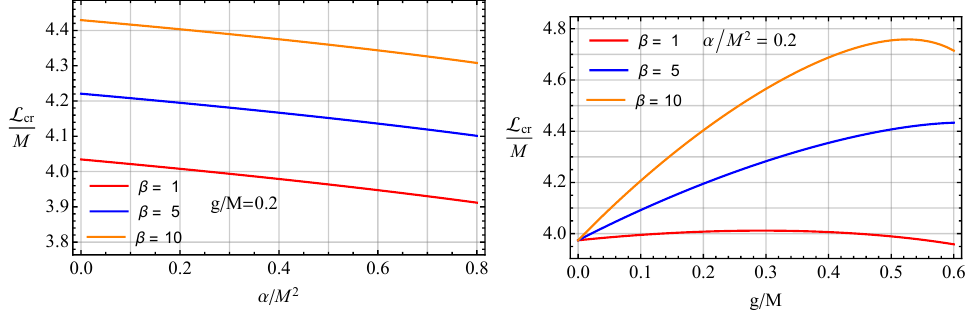
Figure 12. The same figure with Figure 11 but for magnetized